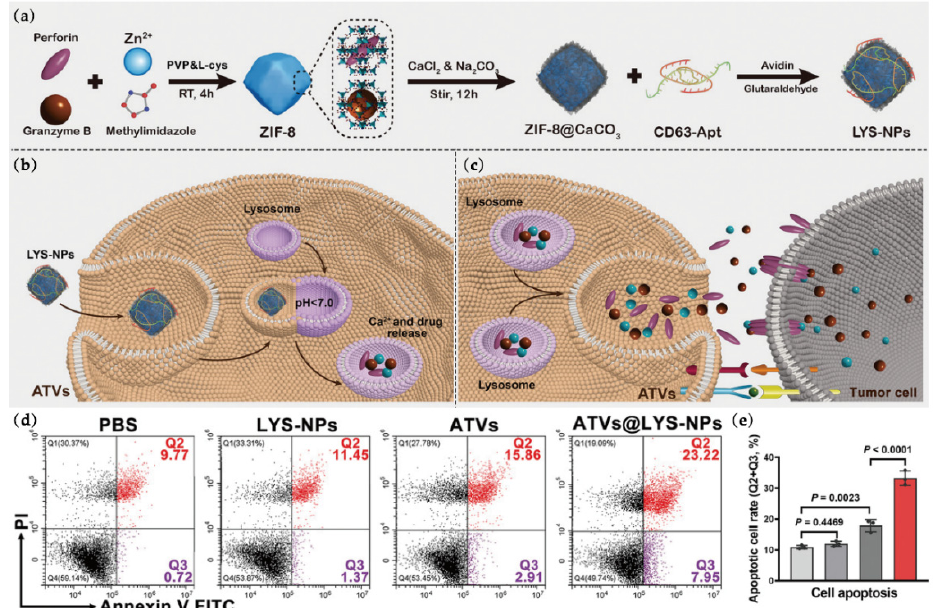
Figure 4. Schematic diagram of the design and synthesis of LYS-NPs and their function. ( a ) Schematic diagram of LYS-NPs synthetic processes; ( b ) schematic illustration of preparing adoptive T cell vectors (ATVs) with LYS-NPs. Once LYS-NPs are taken up by ATVs, they target CD63 + lysosomes and degrade inside to release the contents stored in the lysosomes; ( c ) schematic of ATVs casting cytotoxic proteins and Ca 2+ in reassembled lysosomes to kill target tumor cells; ( d , e ) flow cytometry analysis of 4T1 cells apoptosis level after incubation with PBS, LYS-NPs, ATVs, and ATVs@LYS-NPs for 24 h. Reprinted with permission from Ref. [24]. Copyright 2021 John Willey and Sons.